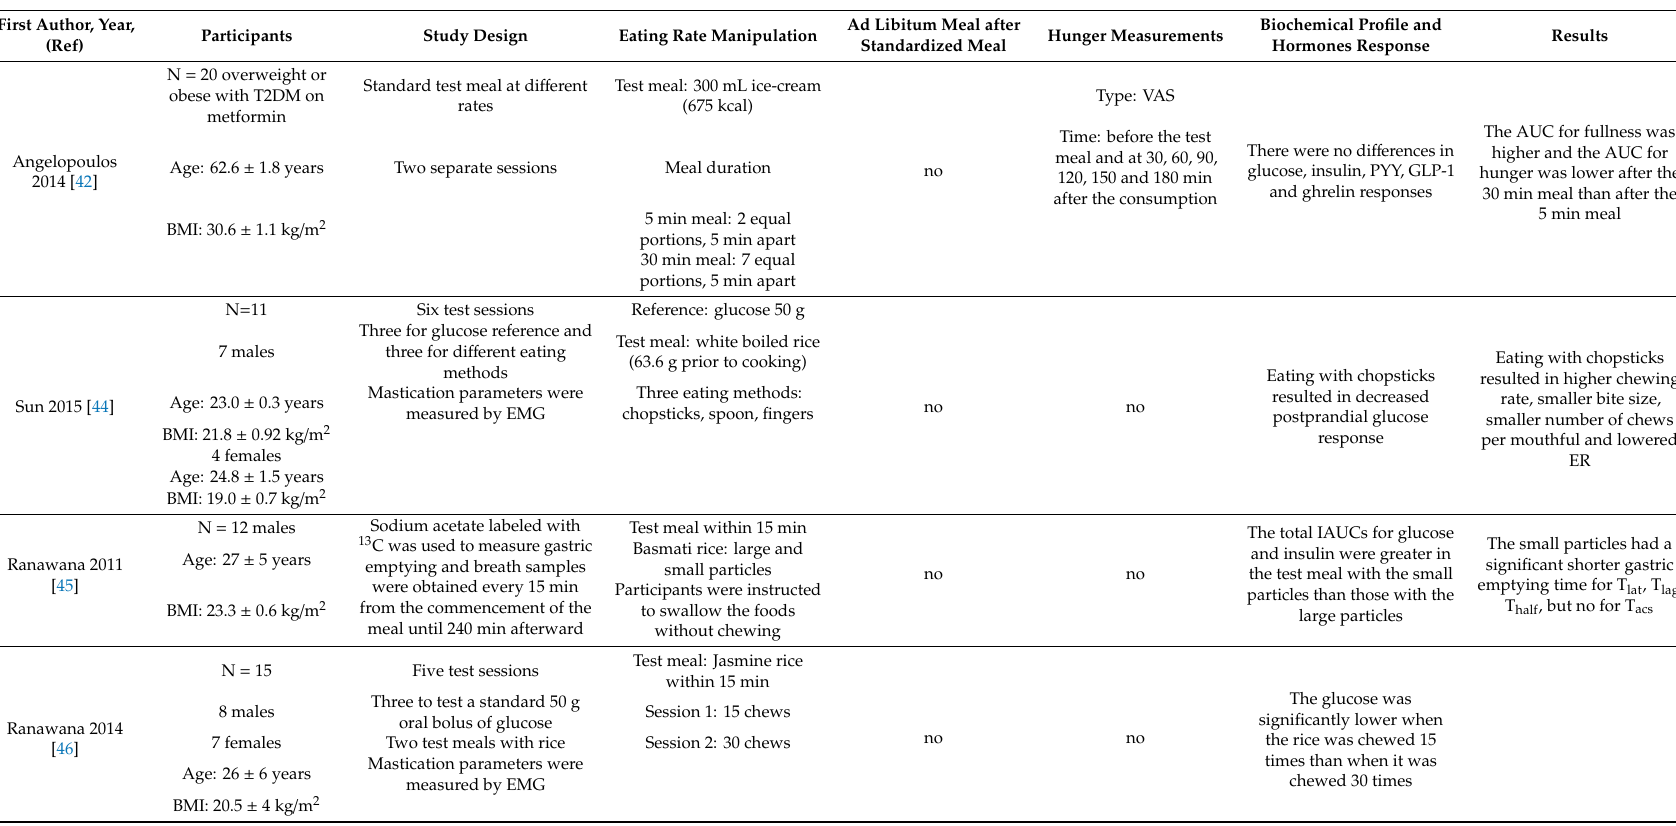
Table 3. Studies concerning patients with diabetes mellitus and the e ff ect of eating rate and mastication on satiety, gut hormones, and glycemic